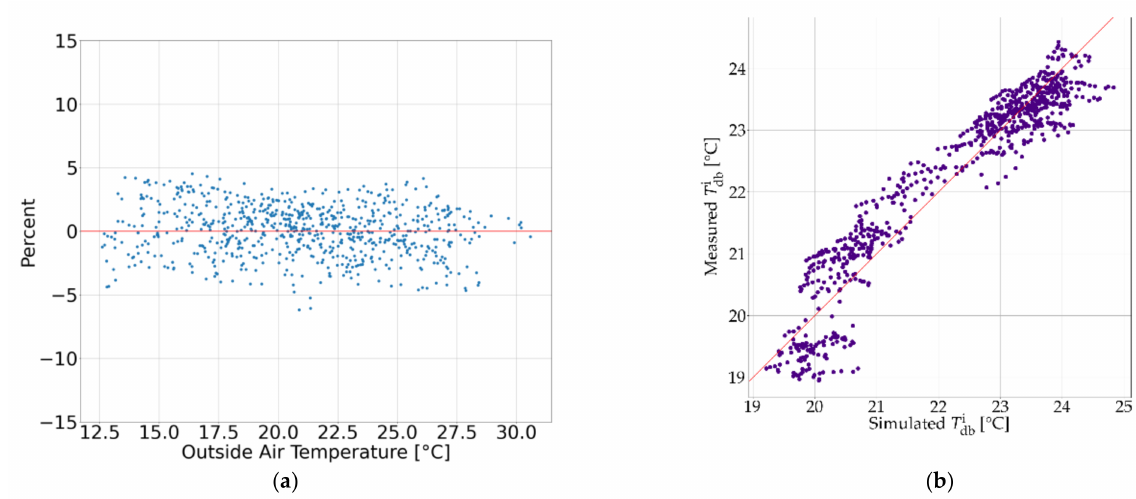
Figure 14. Calibration signature ( a ) and temperatures ( b ) of optimized building model.